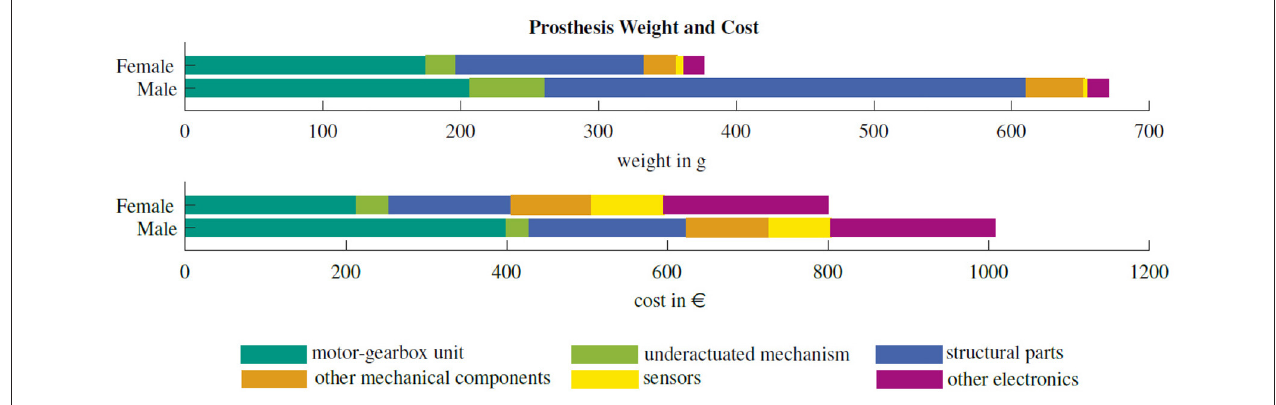
FIGURE 7 | Distribution of weight and cost among the components of the male and female KIT Prosthetic